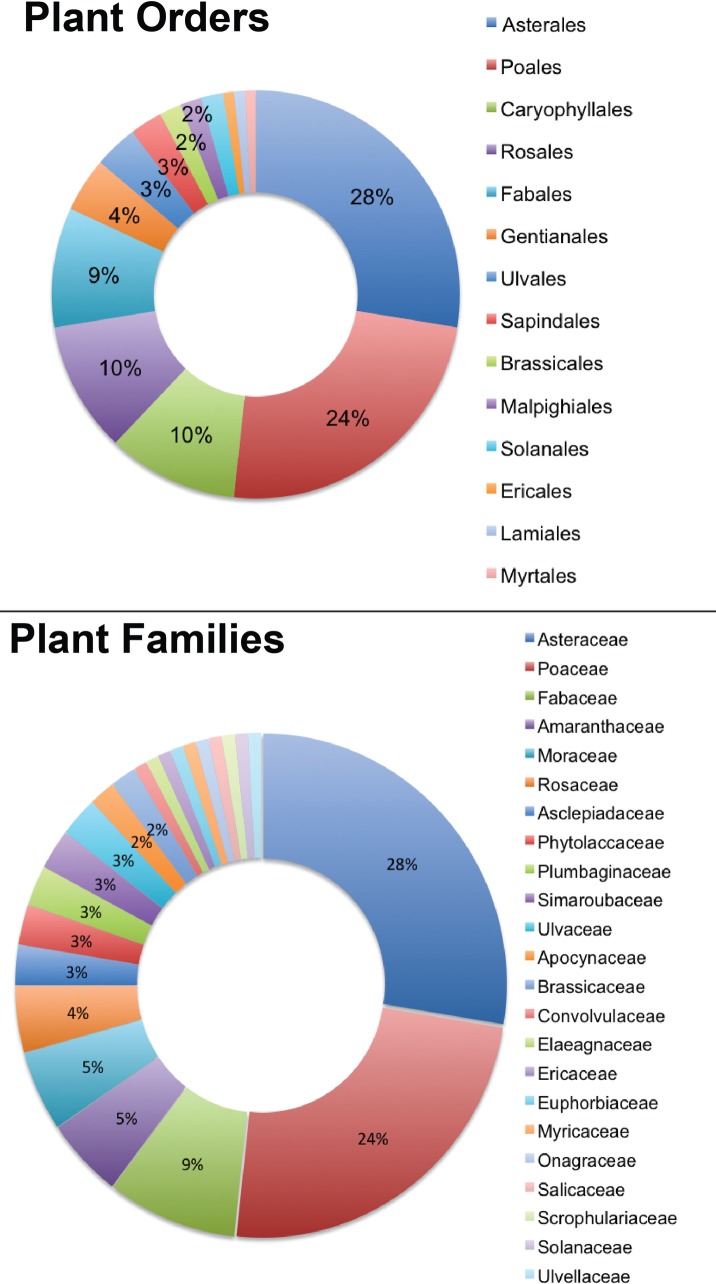
Overview of plants identified by this project, organized by taxonomic level.Of the 116 collected and identified plants the majority were in the Asterales (n = 32; 27.6% of total plants) and Poales (n = 28; 24.1% of total plants) orders, with the highest number of species within each order falling in the Asteraceae (n = 32; 27.6% of total plants) and Poaceae families (n = 28; 24.1%). Taxonomic groups in legends are organized from largest to smallest.